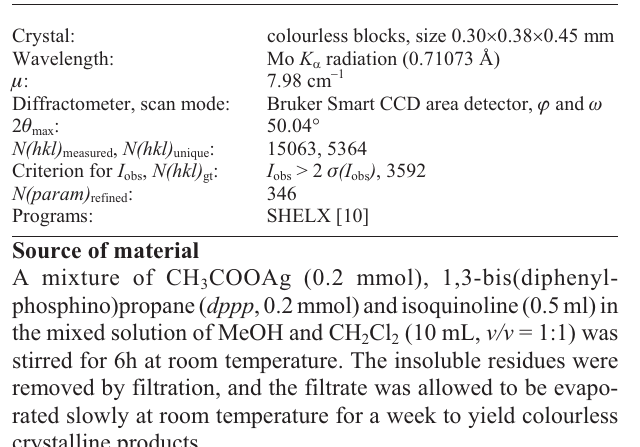
Table 1. Data collection and handling.